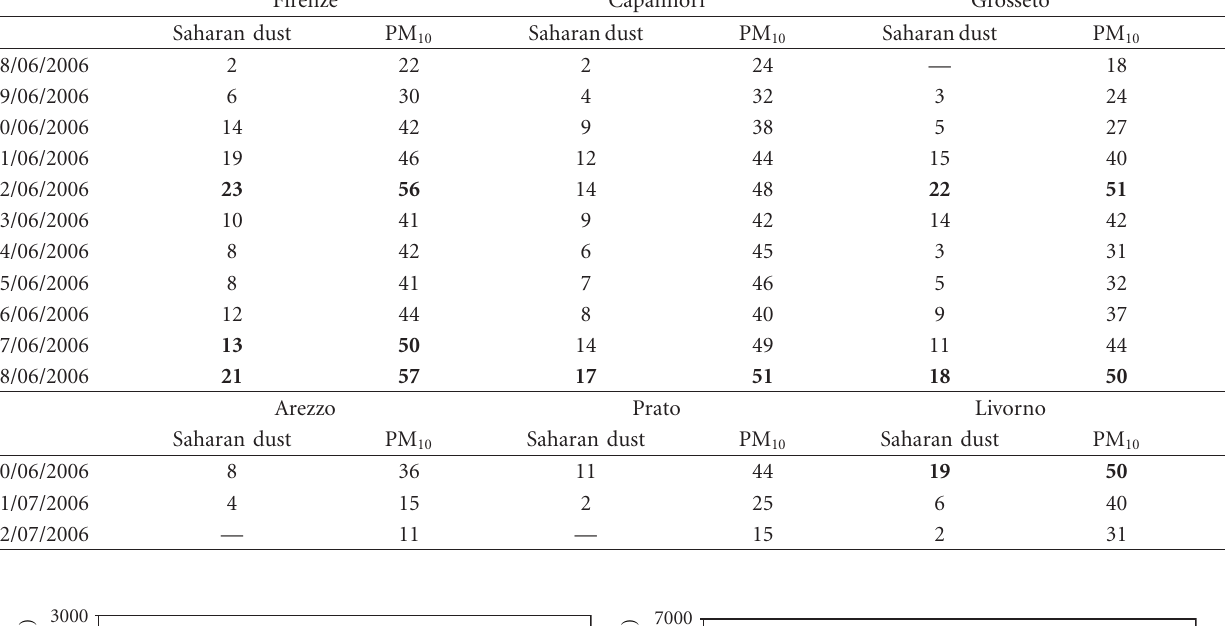
Table 2: Saharan dust and PM 10 concentrations, in µ g/m 3 , during the period of the Saharan intrusion of June 2006, for the six sampling sites (“—” indicates a contribution below the minimum detection limit).